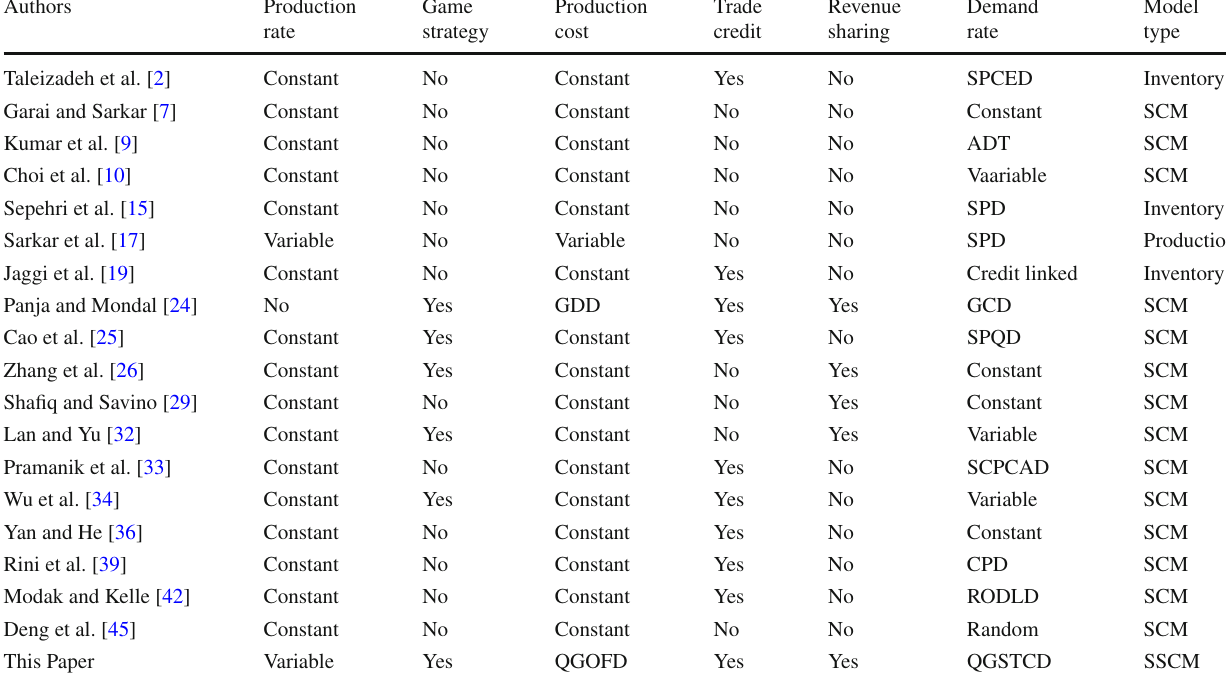
Table 1 Author(s) contribution table